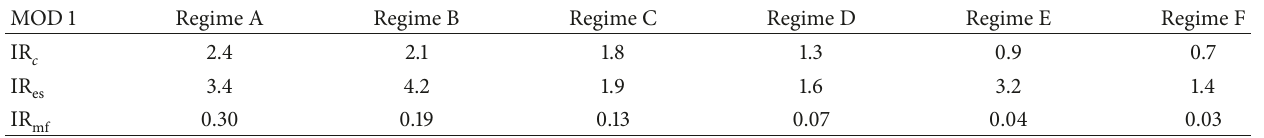
Table 10: Simulation results of MOD 1.